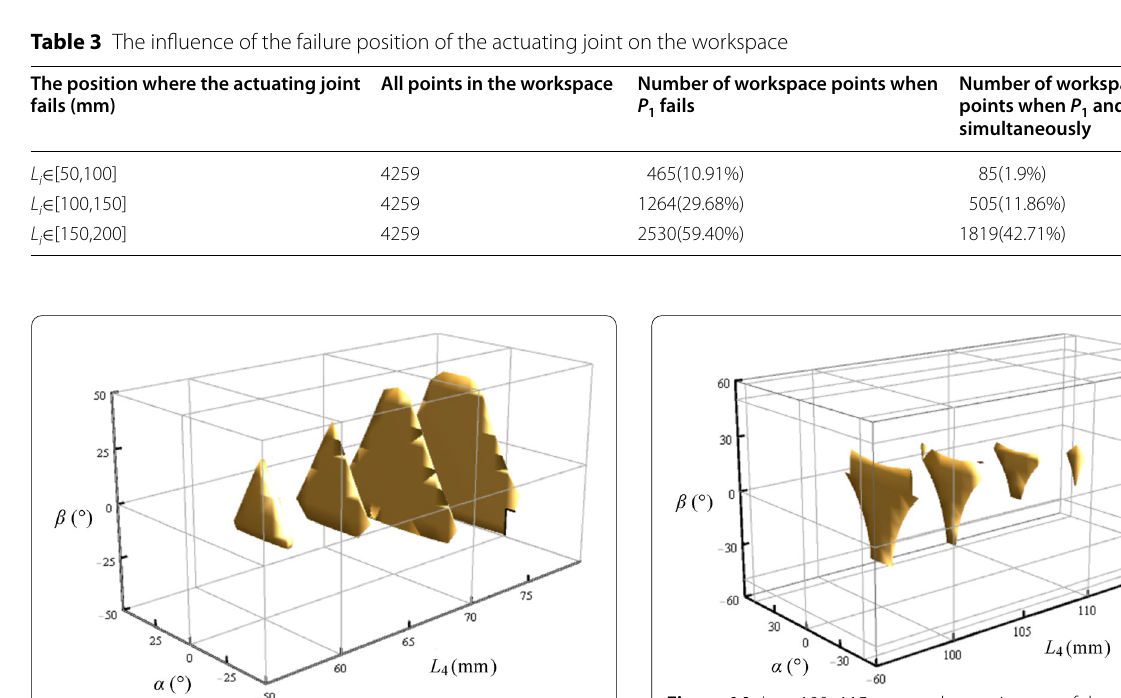
Figure 14 L 4 100–115 mm workspace images of the =